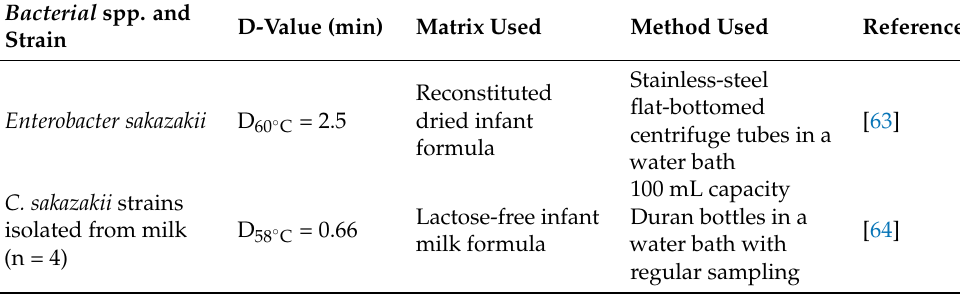
Table 5. Summary of D-values (thermal resistance) for C. sakazakii along with the matrix used. Bacterial spp.